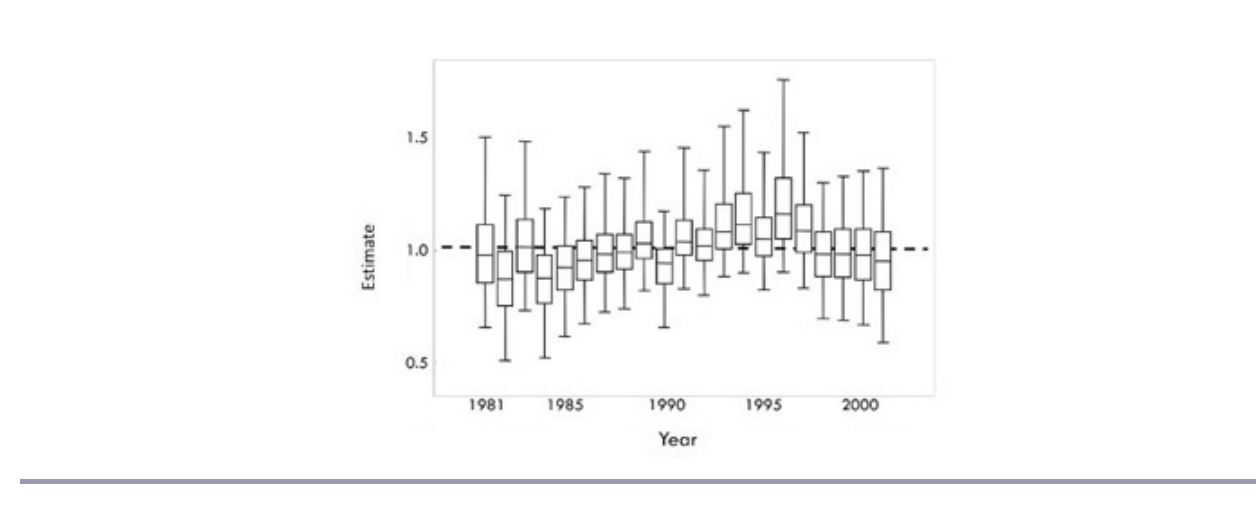
Fig. 1. Posterior estimates of annual relative Golden-winged Warbler ( Vermivora chrysoptera ) abundance after incorporating effects of year and trend. The boxplots represent interquartile ranges and the solid black line bisecting each box is the annual median estimate of abundance; the arms of each box extend to cover the 95% credibile